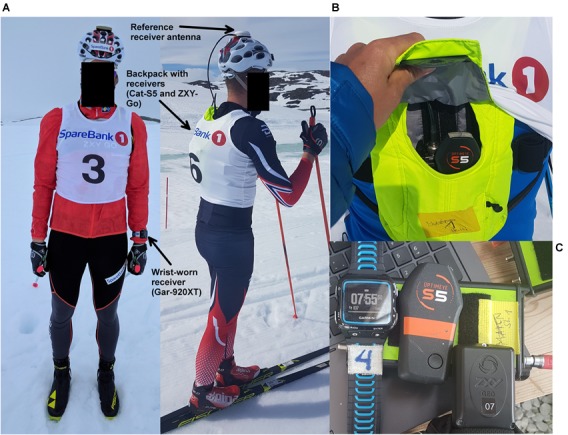
Experimental setup. (A) The reference system antenna was mounted on a bicycle helmet and coupled to the receiver in the backpack (hidden under the start bib). (B) Arrangement of receivers in the backpack. The ZXY-Go receiver was positioned just below the Cat-S5 receiver, and is not visible in this image. The Garmin receiver was worn on the wrist, and is also not visible. (C) The three evaluated receivers (on top, from left to right): Gar-920XT, Cat-S5, and ZXY-Go. Below: Reference receiver (Javad Alpha-G3T).